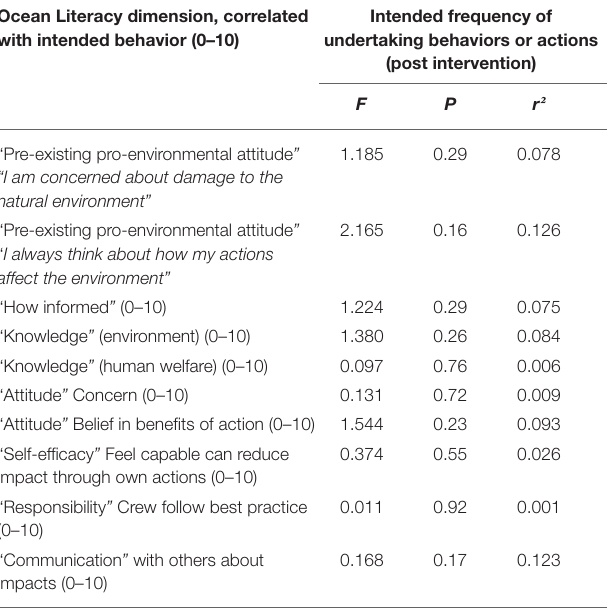
TABLE 6 | Linear regression calculations to assess extent to which predictors of behavior change (awareness, knowledge, attitude, self-efficacy and social norm) predict participants self-reported intended frequency of undertaking behaviors or actions to reduce the effects of invasive species on native marine life. Ocean Literacy dimension, correlated with intended behavior (0–10)